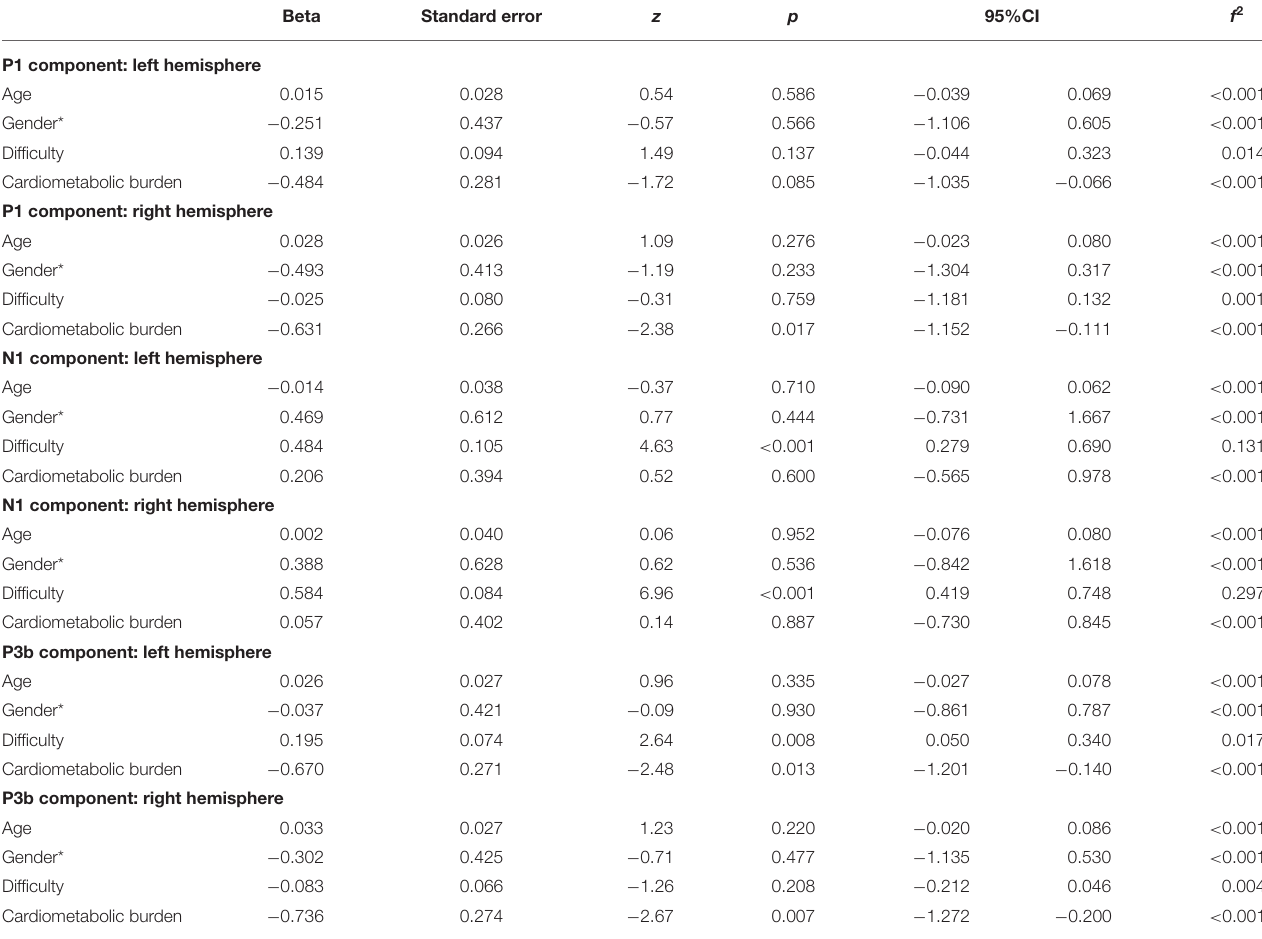
TABLE 4 | Results from mixed effects models for the P1, N1, and P3b ERP component amplitudes stratified by hemisphere (secondary